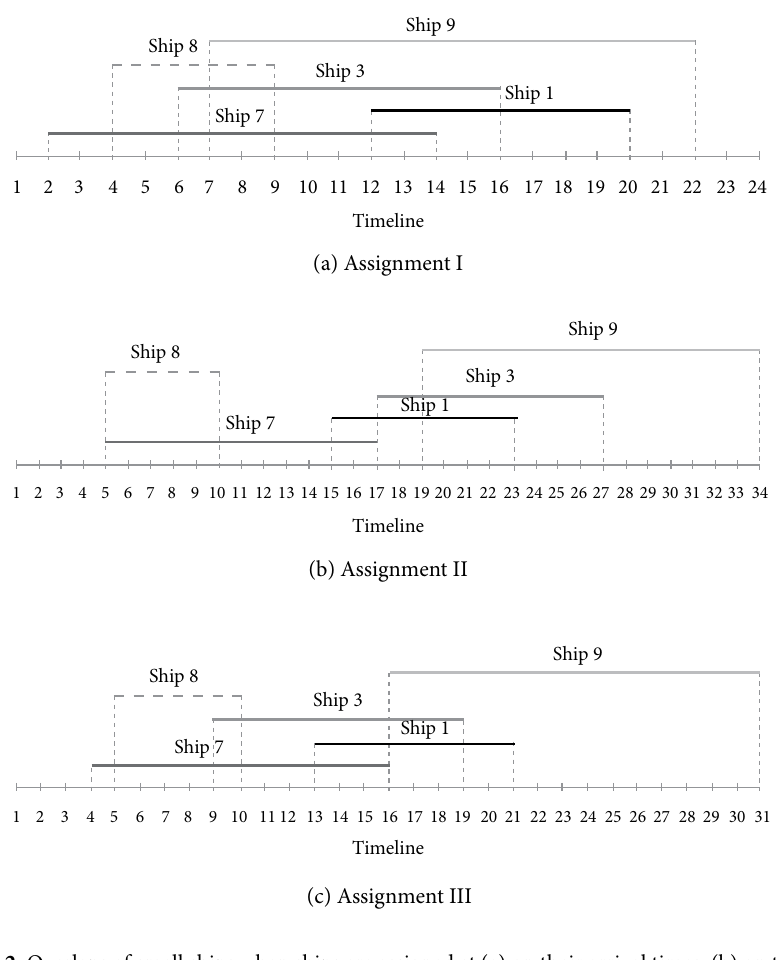
degree(Ship 3) = (24+13+17) / 12 = 4.50 degree(Ship 7) = (22+7+15) / 17 = 2.58 degree(Ship 8) = (10+5+6) / 9 = 2.33 degree(Ship 9) = (26+10+8) / 14 =